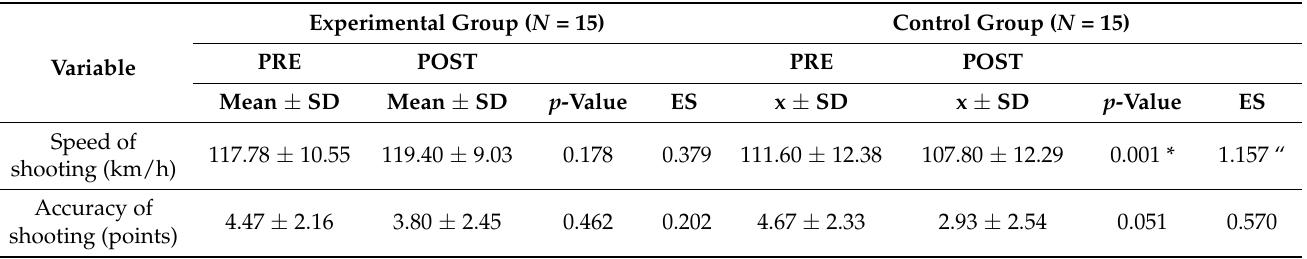
Table 2. Speed and accuracy of shooting: average values at the beginning and after 8 weeks of intervention—experimental group and control group.